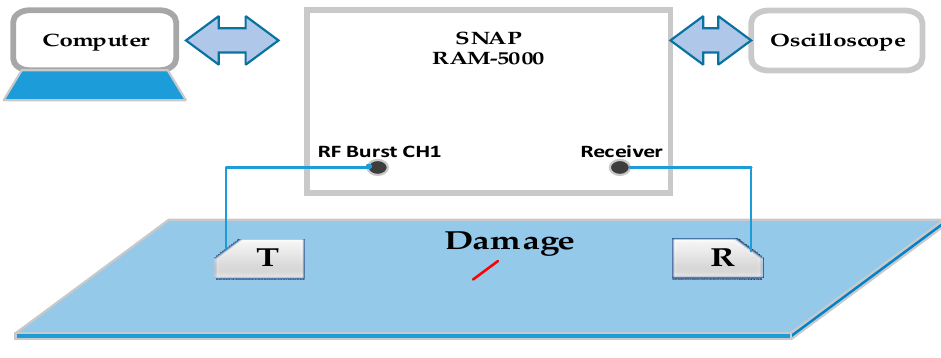
Figure 13. System block diagram of the experiment.